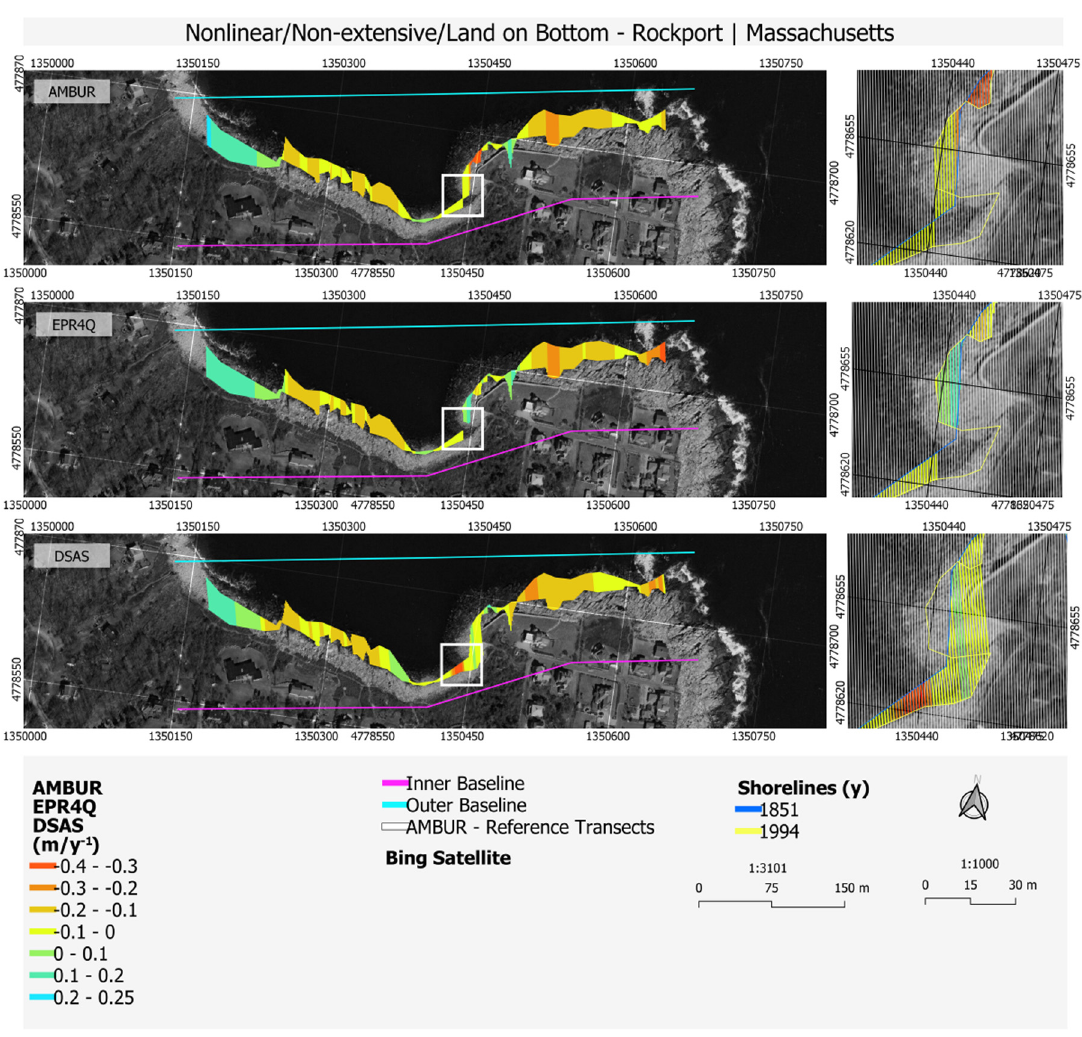
Figure 13. Shoreline changes in Rockport using the AMBUR, EPR4Q, and DSAS tools. White box shows in detail the tools results with the reference transects (AMBUR no filtered transects).